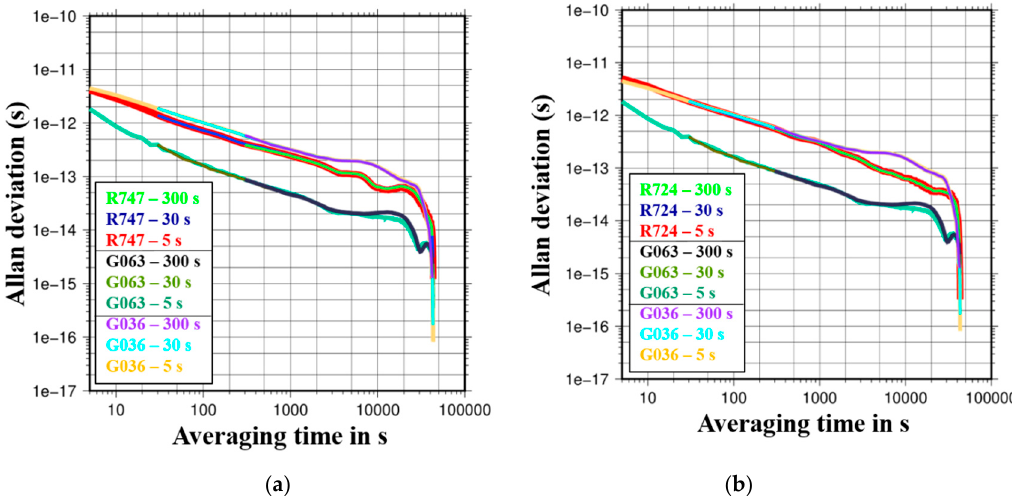
Figure 8. ( a ) Allan deviations for satellites with space vehicle number (SVN) R747, G063, and G036 satellite clock corrections with di ff erent sampling corrections. ( b ) Allan deviations for satellites with space vehicle number (SVN) R724, G063, and G036 satellite clock corrections with di ff erent samplings. Both figures refer to October 27, 2013.